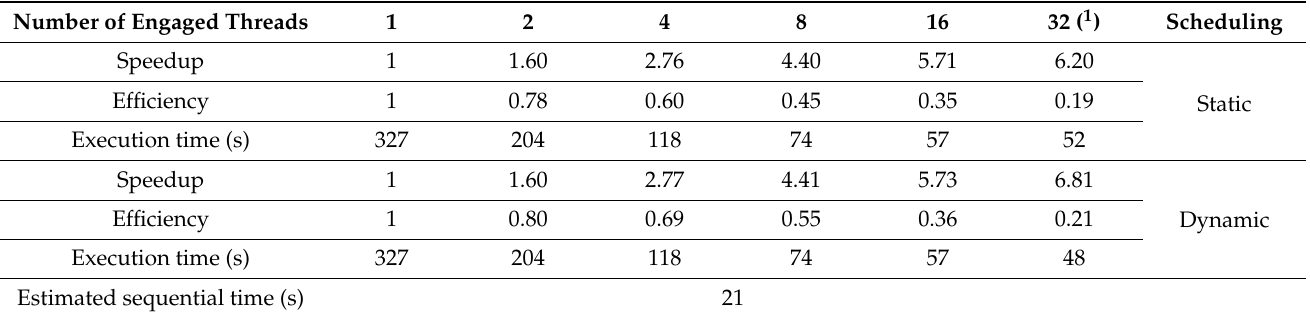
Table 3. Averaged parallel performance achieved on the two eight-core Intel ® Xeon CPU E5-2660 (2.20 GHz) CPU architecture (Platform A) for a 16,600 × 14,200 image